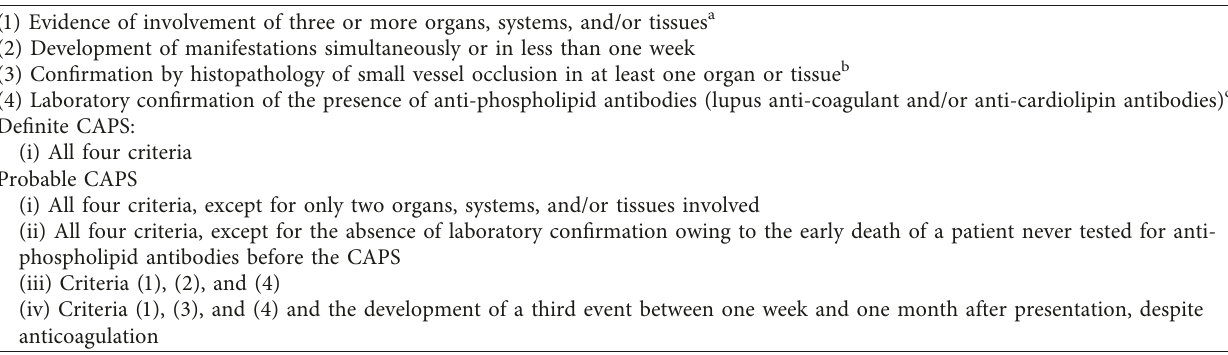
Table 1: Preliminary criteria for the classification of catastrophic antiphospholipid syndrome (CAPS)